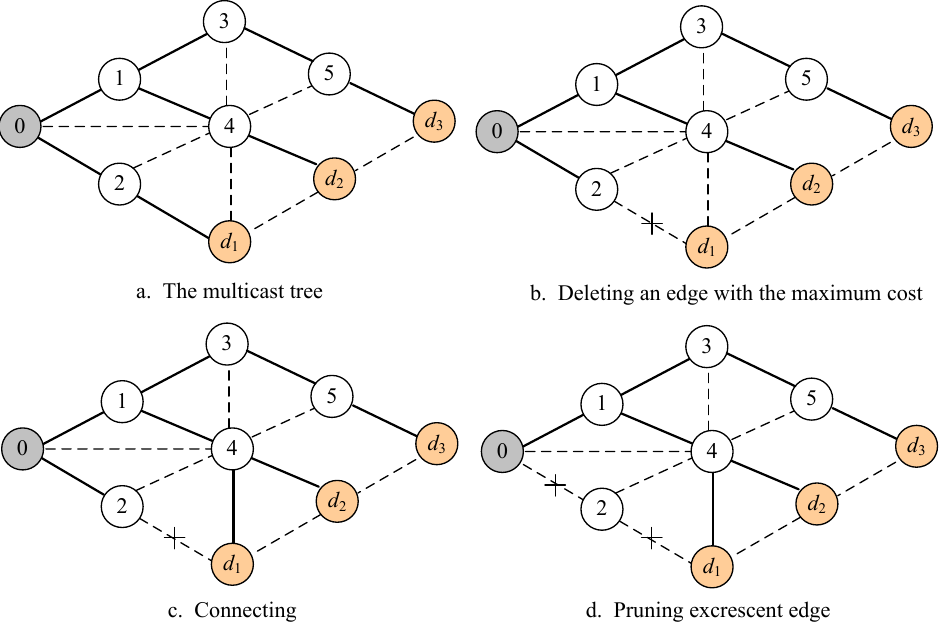
Figure 5. Illustration of solution improvement process.